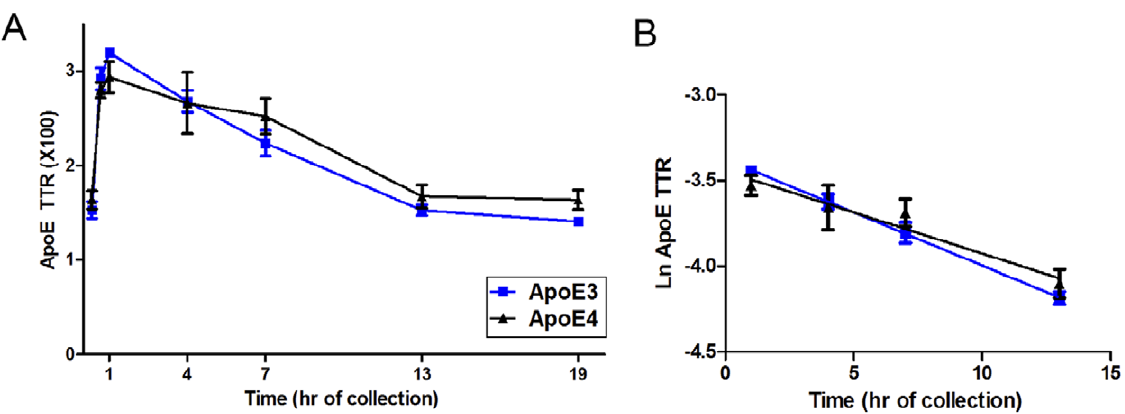
Figure 5. Brain ApoE kinetics in ApoE3 and ApoE4 targeted replacement mice. ApoE was extracted from brains of ApoE3/E3 and ApoE4/E4 mice labeled with 13 C 6 -leucine. Similar kinetics were observed for ApoE3 and ApoE4 mice with monoexponential slopes of 6.2 6 0.48%/h and